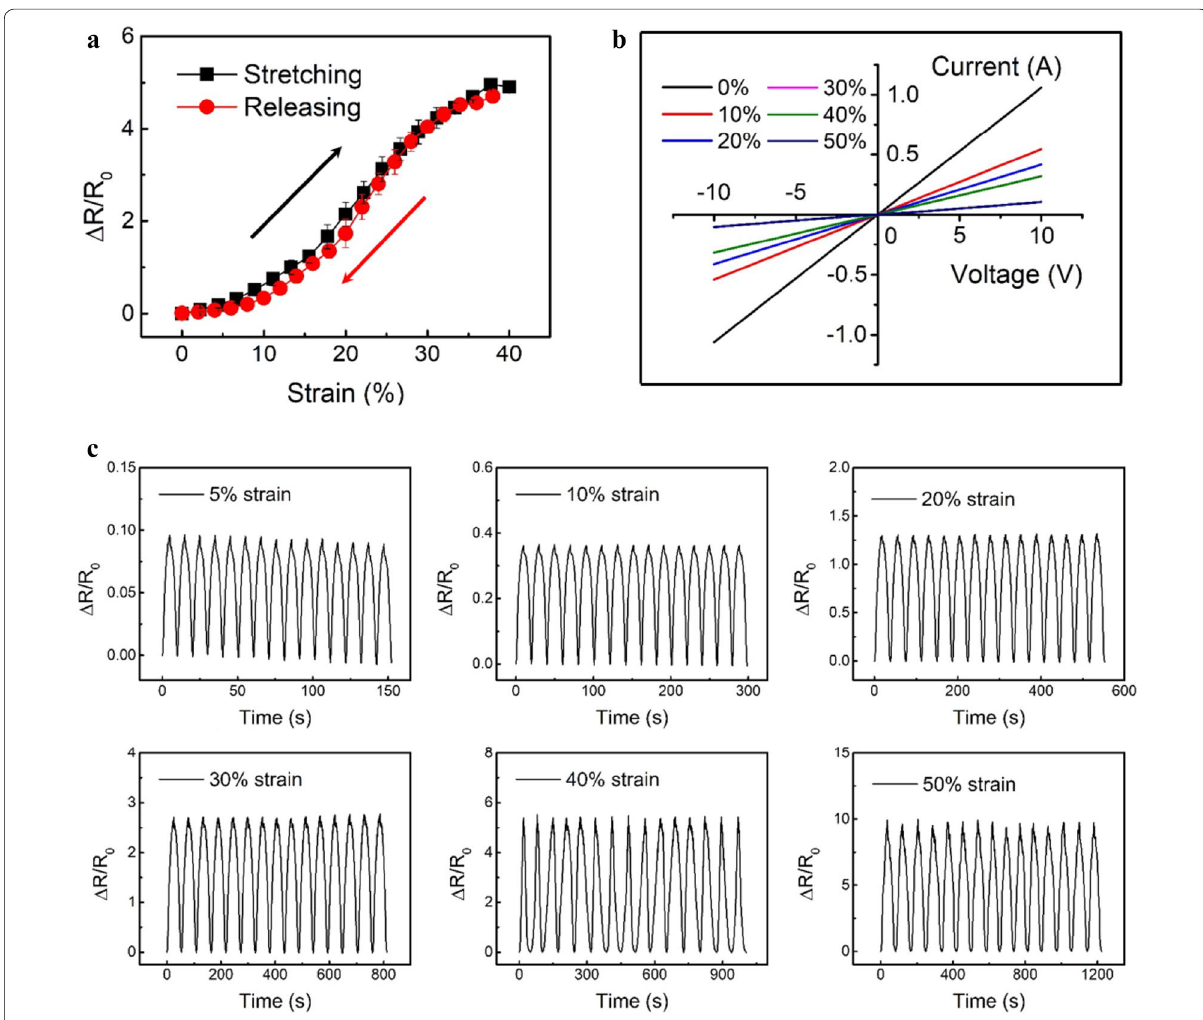
Fig. 5 The measured sensing performance of the piezoresistive strain sensor based on graphene-coated PDMS sponge. a Relative resistance variation of the strain sensor in a 40% strain with stretching/releasing. b Voltage versus current characteristics of sponge at different applied strain. c The measured relative resistance change over fifteen cycles according to time with various maximum